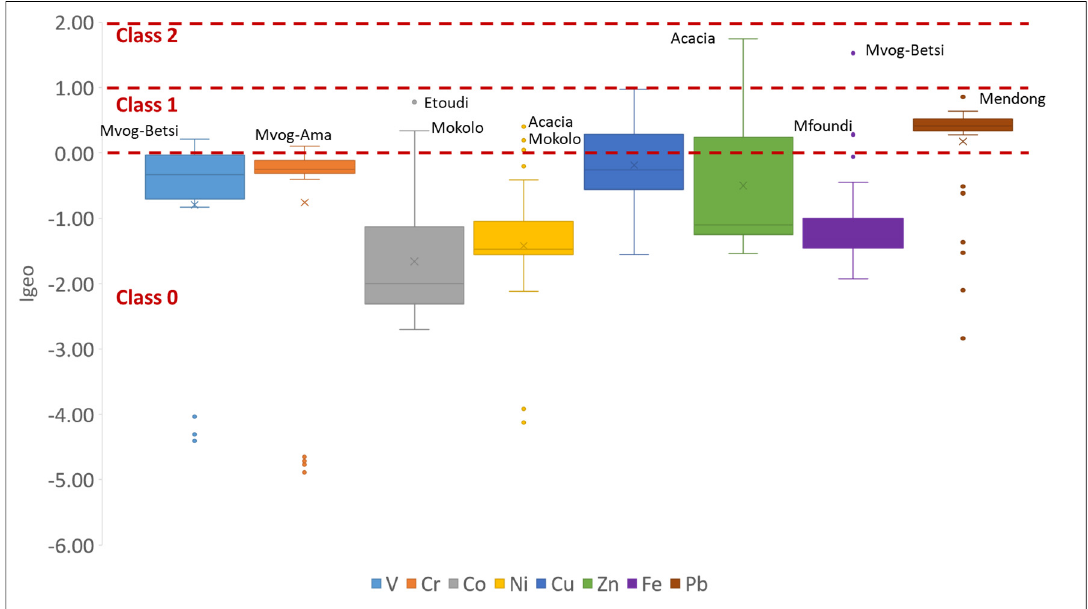
Figure 13. The Igeo of selected metals in the studied geophagic clays.